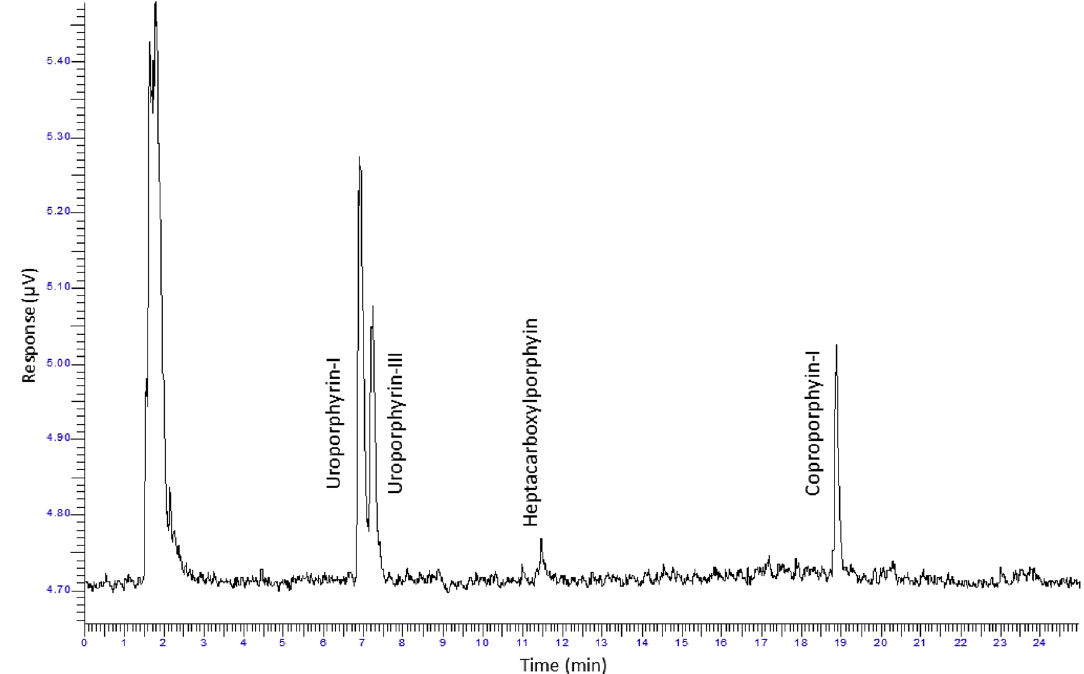
Figure 5. Identification of the porphyrins responsible for biofluorescence in Pedetidae. High performance liquid chromatograph of extracted pigment from captive Pedetes capensis fur. The response times in this sample were compared to that of a standard mixture of porphyrins (Supplementary Fig S1) which allowed for identification of uroporphyrin-I, uroporphyrin-III, heptacarboxylporphyrin, and coproporphyrin-I in the sample. The peak centered around two minutes has not been assigned and does not correspond to any of the porphyrins in the standard mix (uroporphyrin, heptacarboxylporphyrin, hexacarboxylporphyin, pentacarboxylporphyrin, coproporphyrin, and